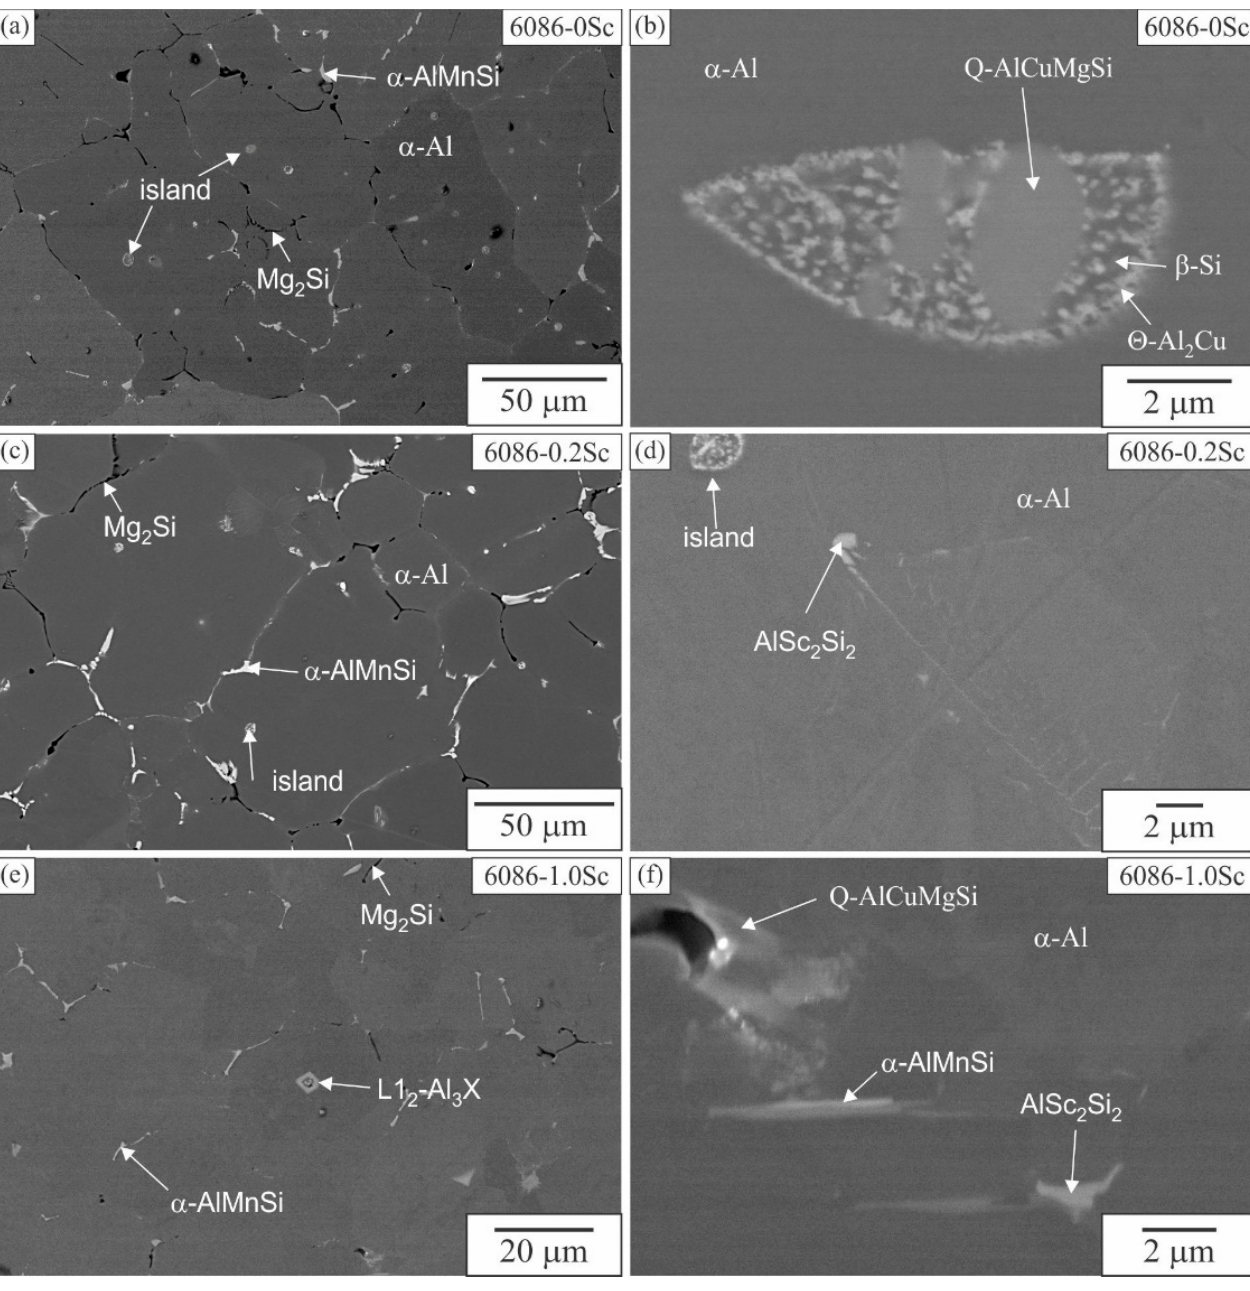
Figure 8. Backscattered electron (BSE) micrographs of the investigated alloys in the as-cast condition. The alloy 6086-0Sc at ( a ) a lower and ( b ) a higher magnification; the alloy 6086-0.2Sc at ( c ) a lower and ( d ) a higher magnification and the alloy 6086-1Sc at ( e ) a lower and ( f ) a higher magnification.